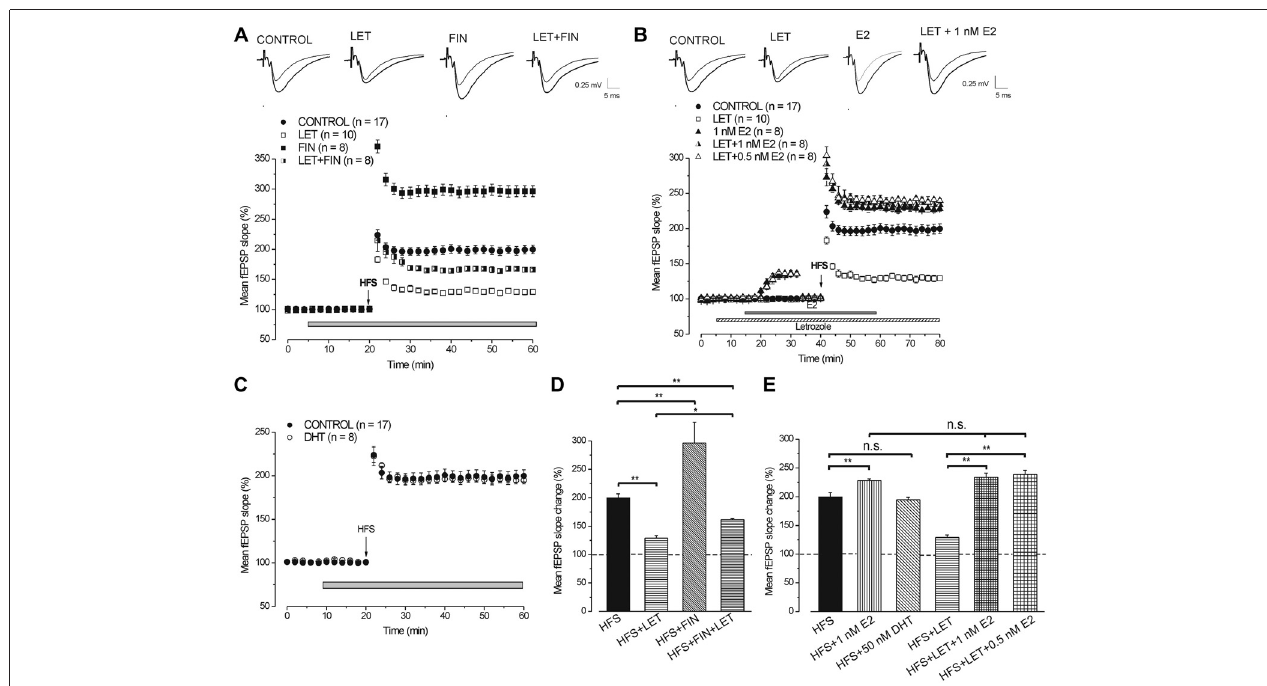
FIGURE 4 | Neo-synthesis of E2 is involved in the full development of HFS-LTP. (A,B) On the top averaged traces ( n = 20) of fEPSPs recorded before (thin traces) and 40 min after HFS (thick traces) in different experimental conditions. (A) Effect of HFS in control condition (filled circles), under LET (open squares), FIN (filled squares) and LET + FIN (half-filled squares). (B) Effect of HFS in control condition (filled circles), in the presence of LET (open squares), 1 nM E2 (filled triangles), LET + 1 nM E2 (half-filled triangles) and LET + 0.5 nM E2 (open triangles). (C) Effect of HFS in control condition (filled circles) and in the presence of 50 nM DHT (open circles). (D) Comparison among LTP induced by HFS in control condition and under blockade of E2 and DHT synthesis as shown in (A) (one-way ANOVA, F 3,39 = 87.7, p < 0.0001; Tukey’s post hoc test ∗∗ p < 0.001, ∗ p < 0.05). (E) Comparison among LTP induced by HFS in control condition, under exogenous DHT and E2 with or without LET (one-way ANOVA, F 5,54 = 42.6, p < 0.0001; Tukey’s post hoc test ∗∗ p < 0.001). Note that for the full development of HFS-LTP the synthesis of E2 is mainly requested and the block of DHT synthesis further increases